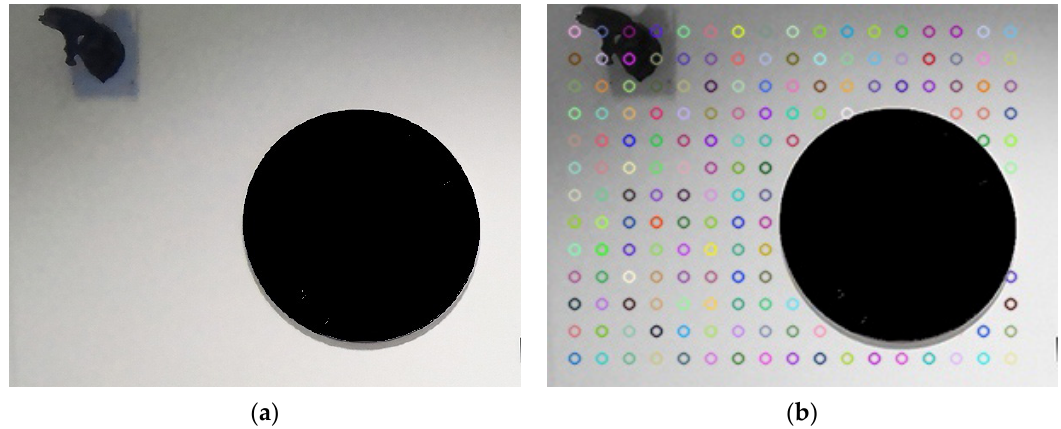
Figure 14. ARAC background feature extraction. The uniformly distributed circles of various colours in the background area represent the feature points extracted in this area: ( a ) origin background image; ( b ) background feature extracted by ARAC.